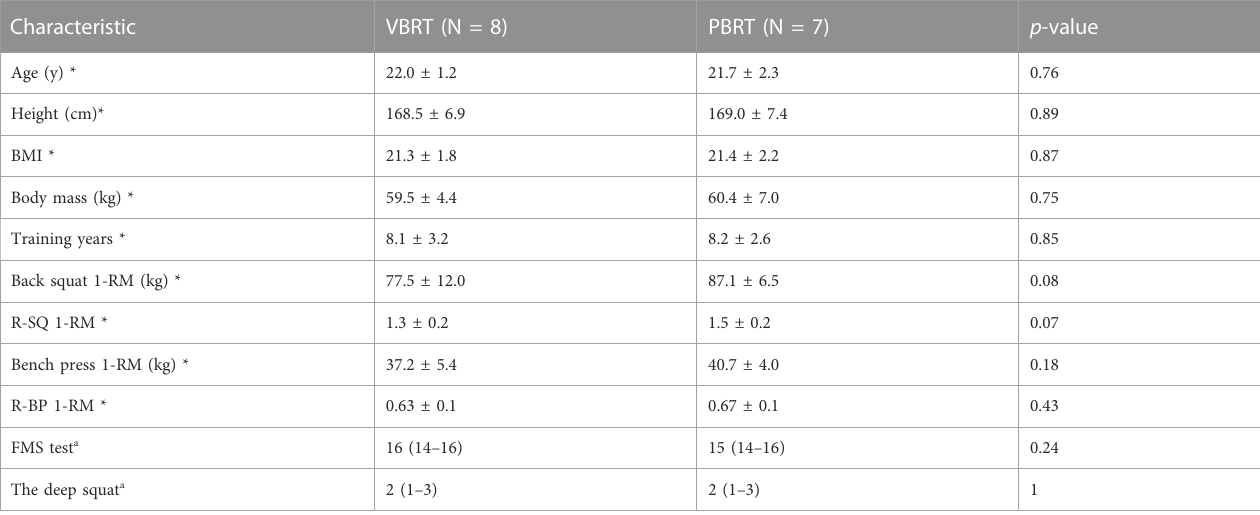
TABLE 1 Baseline participant